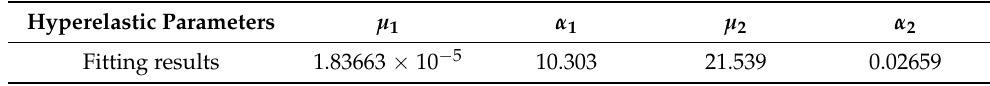
Figure 4. Correlation of the second order Ogden model with test data. The hyperelastic parameters of the Ogden model in Table 1 were substituted into Equation (7) and Equation (10), and the W c and the W c / W ratio under two typical strain states of uniaxial tension and simple shear were calculated. The distribution of W c and W c / W with respect to the first principal elongation λ 1 (1. 2 ≤ λ 1 ≤ 10) and crack angle θ (- π ≤ θ ≤ π) are shown in Figure 5 and Figure 6.